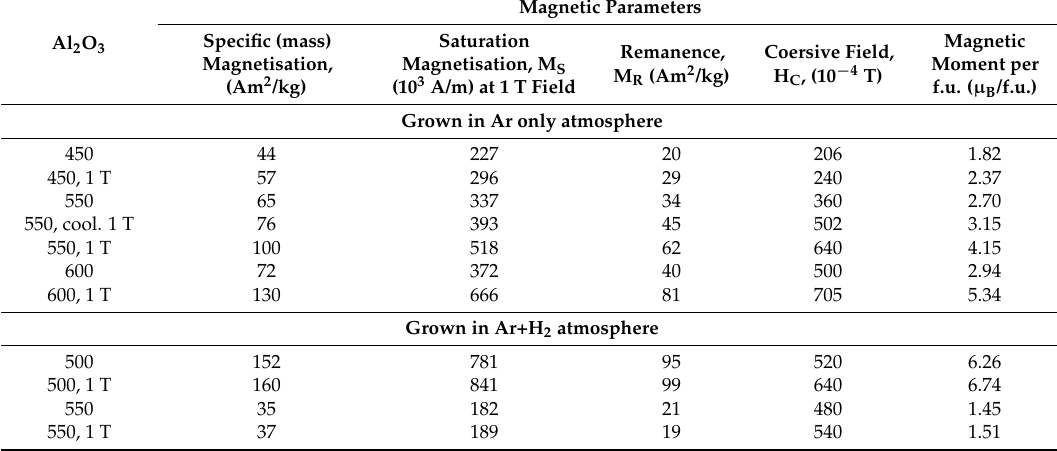
Table 2. The magnetic properties of Fe 3 O 4 films grown on Al 2 O 3 at different deposition parameters.